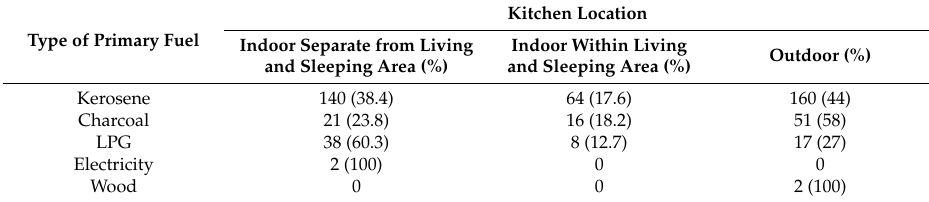
Table 3. Location of kitchen among primary fuel users.